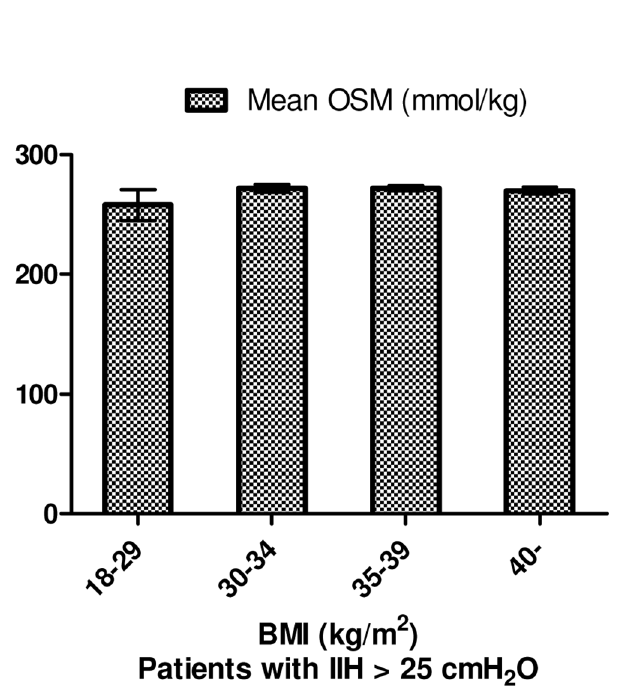
Fig 4. BMI Groups. All 66 participants, 25 unpaired samples. Error bars based on SE.